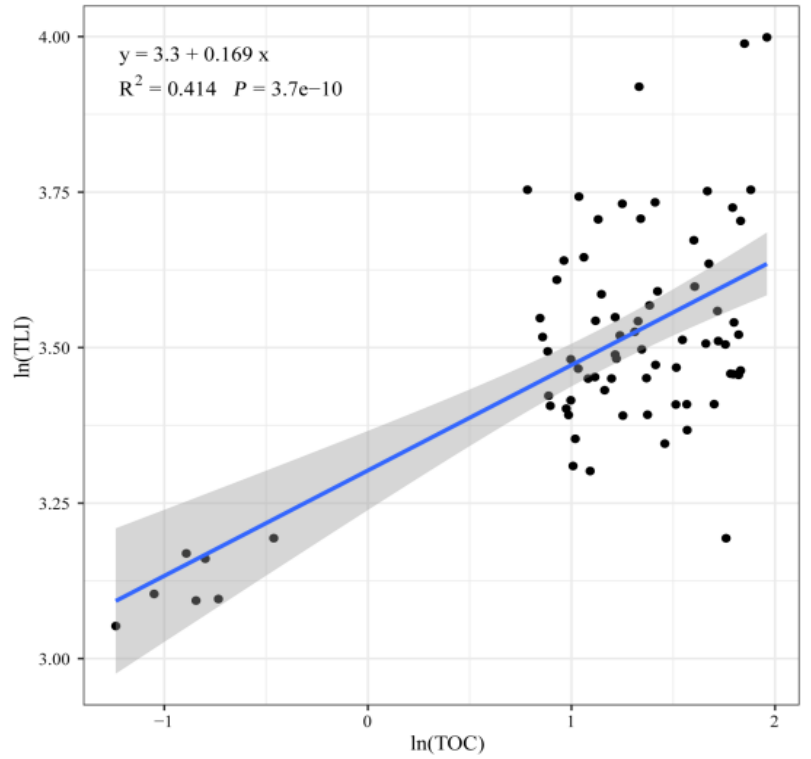
Figure 8. Linear regression analysis of TLI and TOC concentration.